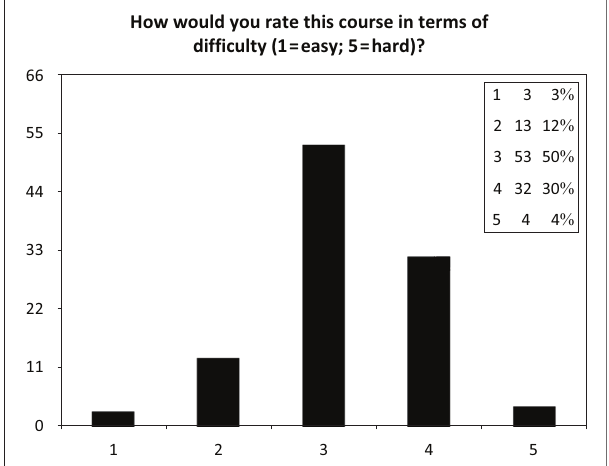
FIGURE 3: Scores on pre- and post-test.